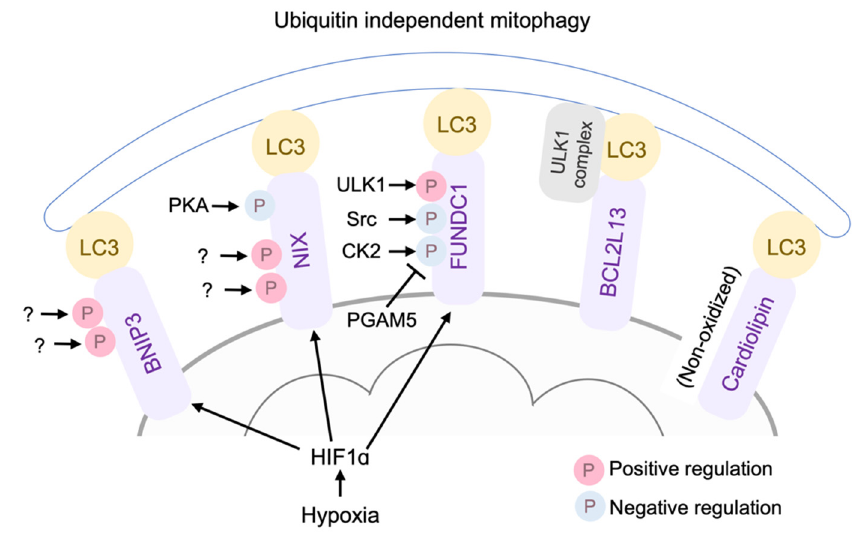
Figure 4. Ubiquitin independent mitophagy mechanisms. BNIP3, NIX/BNIP3L, FUNDC1, BCL2L13, and cardiolipin function as LC3 receptors, targeting damaged mitochondria for autophagosomal engulfment and clearance.